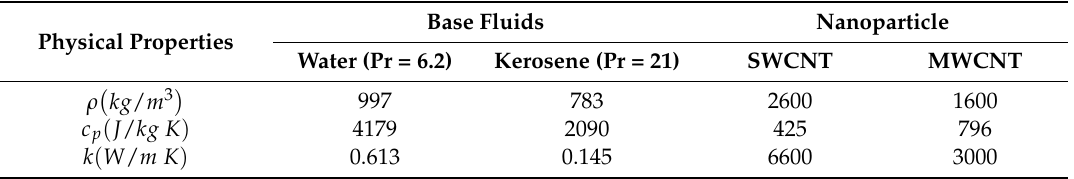
Table 1. Thermophysical properties of CNTs (Khan et al. [22]).